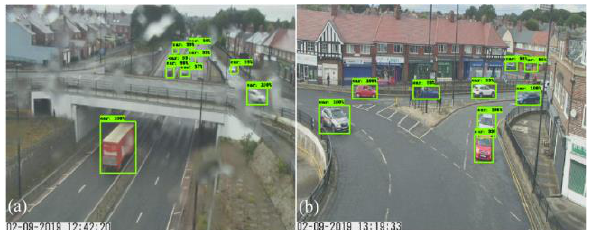
Figure 2. CCTV vechicle recognition using a Convolution Neural Network (R-CNN) for (a) raining conditions, (b) dry conditions.